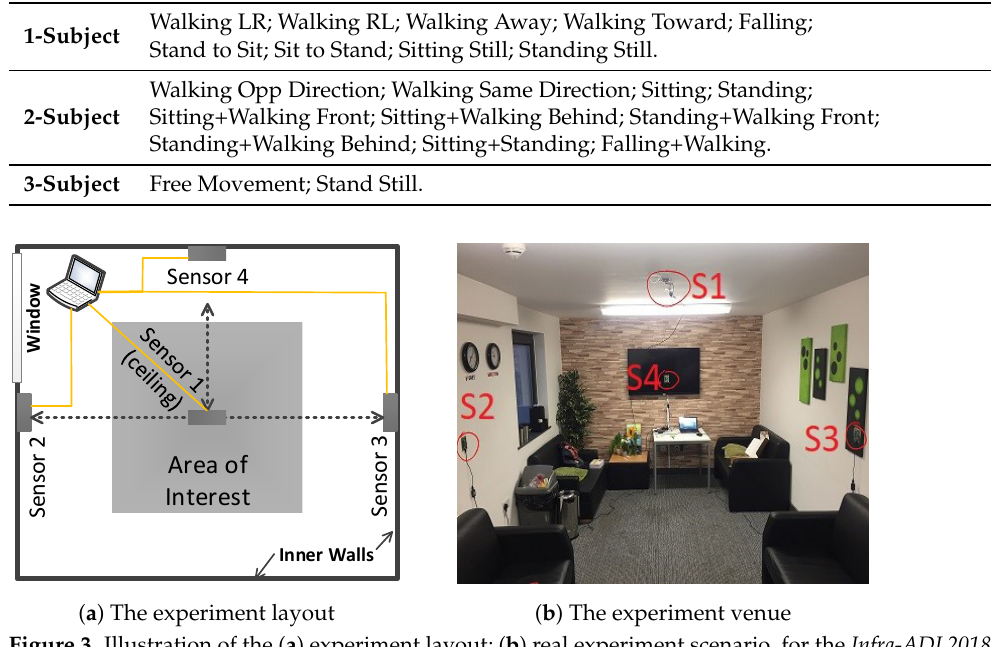
Table 2. The three categories of activities of the Infra-ADL2018 dataset.